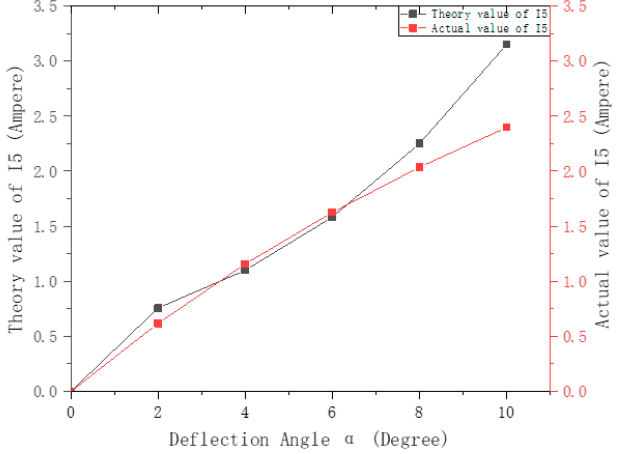
Figure 15. The actual input electric current of 𝑰⃗(𝑰 𝟏 𝑰 𝟐 𝑰 𝟑 𝑰 𝟒 𝑰 𝟓 ) and its theoretical value in different deflection angles 𝜶(𝑰⃗) . 𝑰 𝟏 is set as 2 A, 𝑰 𝟐 and 𝑰 𝟑 is set as 1.5 A, 𝑰 𝟒 is set as 0 A.